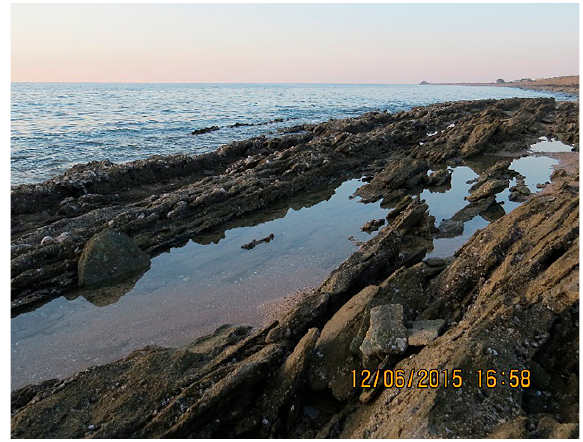
Figure 3. Gatan shore, Hormuzgan Province, Iran; new collection site for F. reichei .